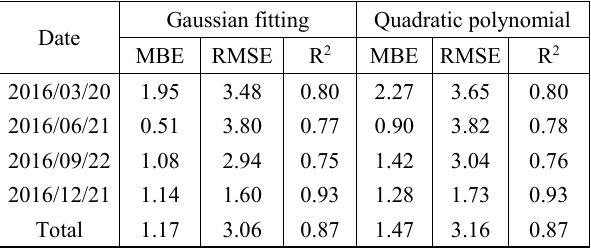
Table 2 . Comparison between the Gaussian fitting and uadratic polynomial methods (MJ/m2)